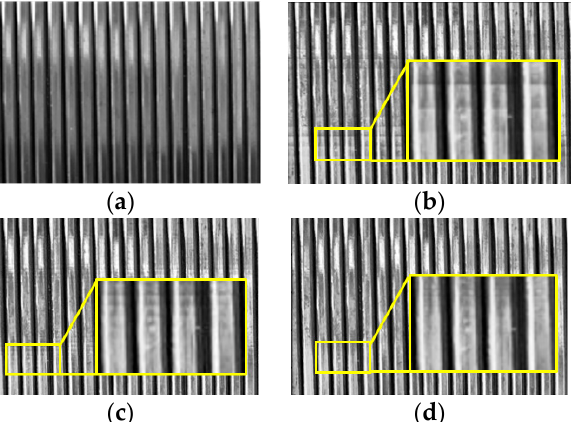
Figure 9. Comparison of different slice values: ( a ) origin gray image; ( b ) n equal 20; ( c ) n equal 40; ( d ) n equal 80.